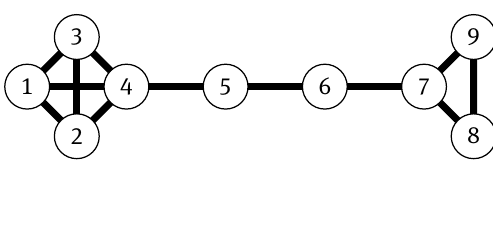
Figure 1: KPK 4,4,3 Table 1: The maximum ρ D L and graph that achieves it for all graphs on 10 or fewer vertices